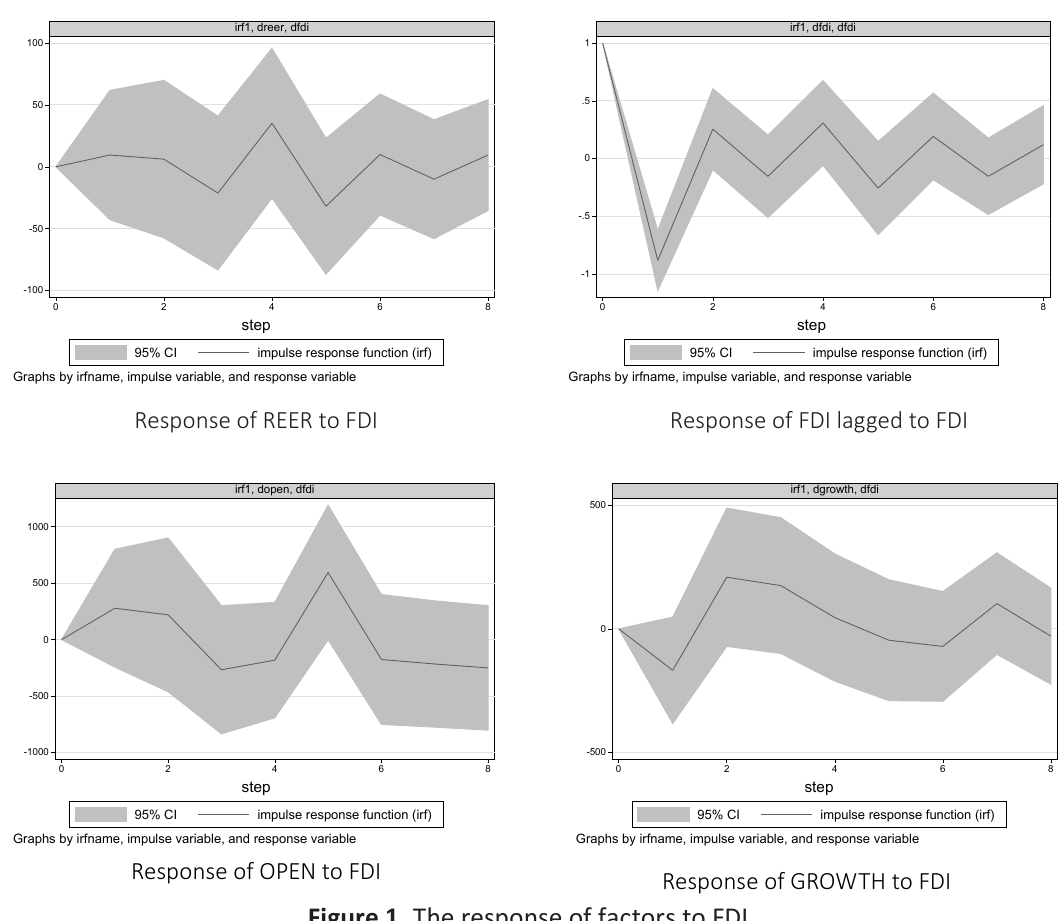
Figure 1. The response of factors to FDI